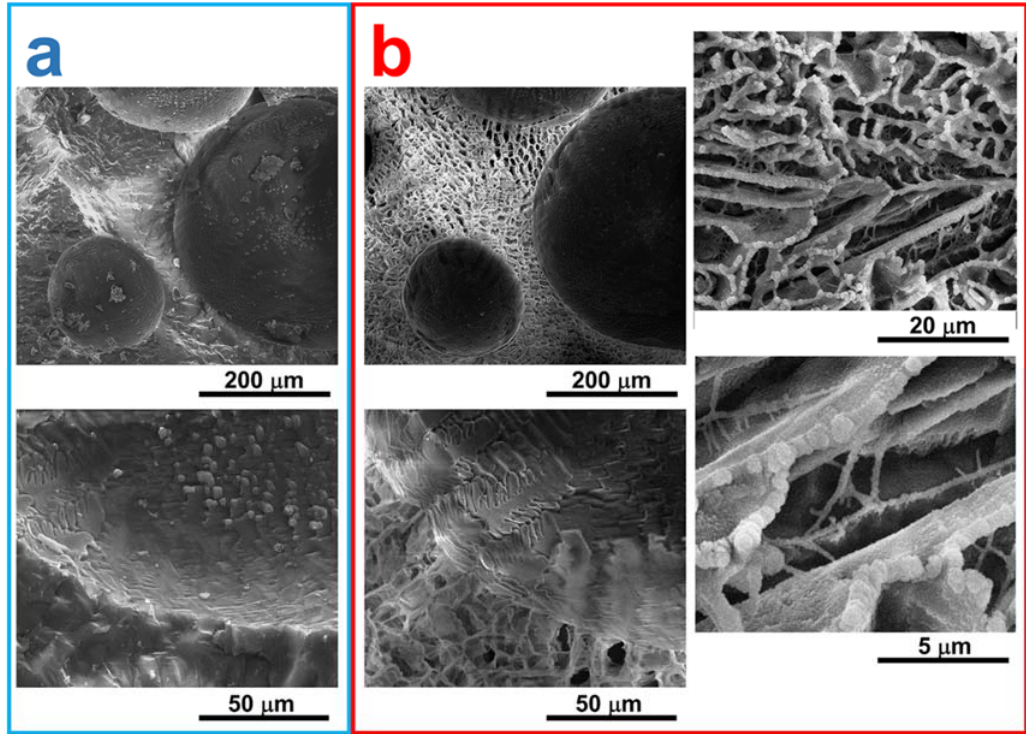
Figure 2. Cryo-SEM images of the sample PVA-MFC5: ( a ) Sample frozen in liquid nitrogen and observed at − 140 °C; ( b ) Same areas of the sample after water sublimation at − 80 °C.